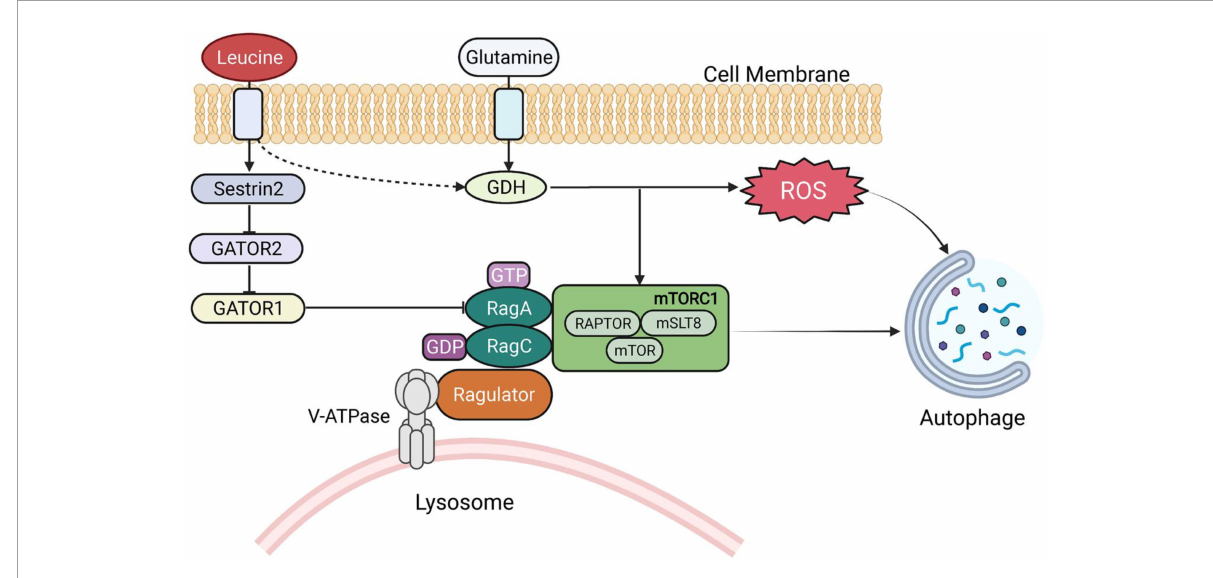
FIGURE2 BCAA-regulated signaling pathways. GDH, glutamate dehydrogenase; RAG, RAS-related GTP-binding proteins; ROS, reactive oxygen species.